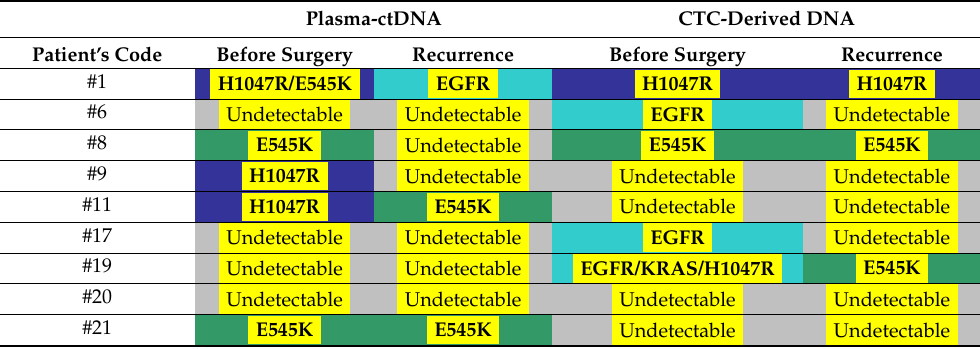
Table 2. Comparison of mutations detected in (a) plasma- cfDNA isolated from plasma before surgery and at disease recurrence ( n = 9) and in (b) CTC-derived gDNA before surgery and at disease recurrence ( n = 9). Plasma-ctDNA CTC-Derived DNA Patient’s Code Before